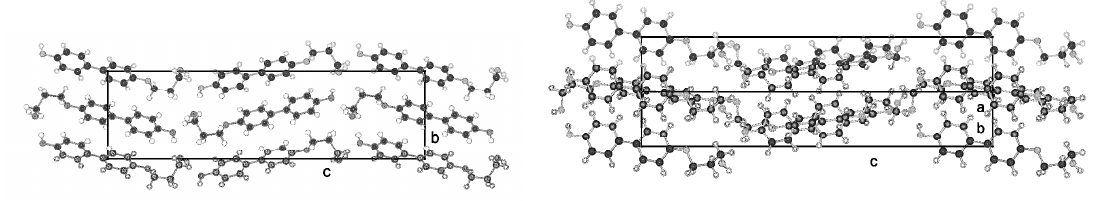
Figure 3. Representation of the antiparallel arrangement of H3HBP in space group P2 projected along [100] and along the diagonal of the a,b-plane.